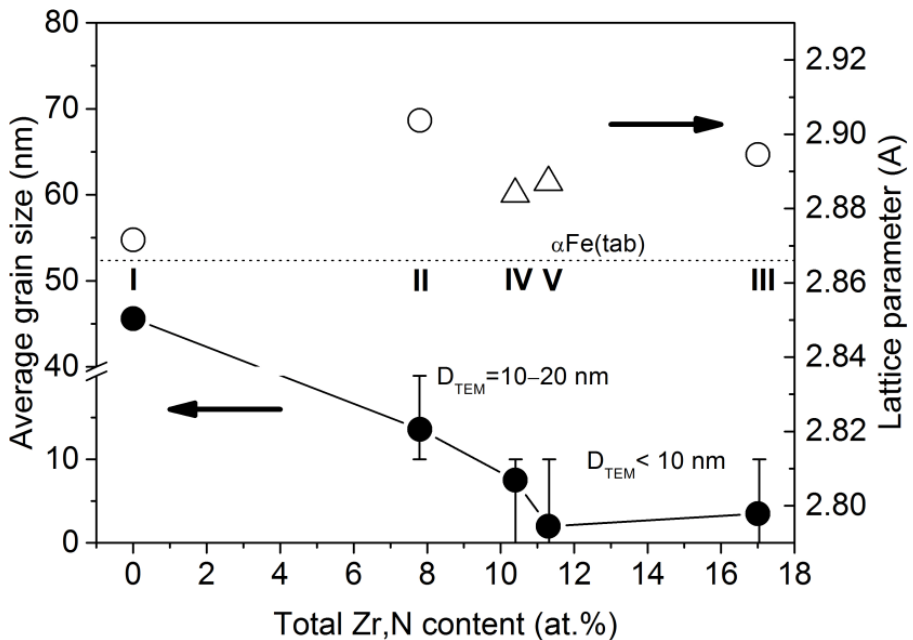
Figure 4. The influence of the total content of Zr and N on the lattice parameter of the bcc phase in the single-phase (open circles) and two-phase (open triangles) films and the average grain size of the bcc phase, estimated by XRD (filled circles) and TEM (hatching) in the as-deposited films. The XRD pattern exhibits, along with strong narrow reflections corresponding to crystalline Fe-based bcc phase, wide reflections strongly diffused and superimposed on crystalline phase reflections centered at 2 θ ~39–40 ◦ (Figure 3a). The latter correspond to the amorphous (most likely in terms of XRD) phase. The presence of amorphous phase XRD patterns taken from the films (Figure 3a) to a 100%-Fe crystalline standard, which is less than unity. The wide reflections had not been resolved in frame of this